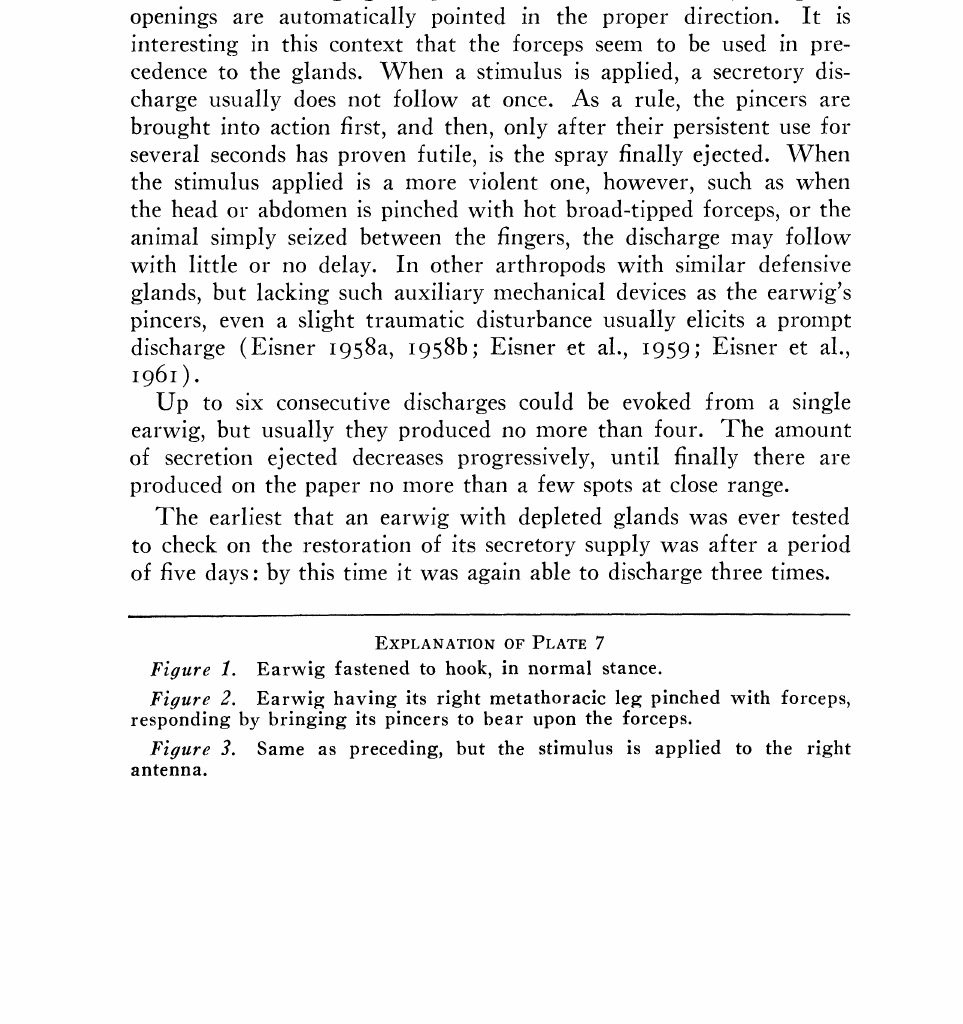
Figure 1. Earwig fastened to hook, in normal stance. Figure 2. Earwig having its right metathoracic leg; pinched with forceps, responding by bringing its pincers to bear upon the forceps. Figure 3. Same as preceding, but the stimulus is applied to the right